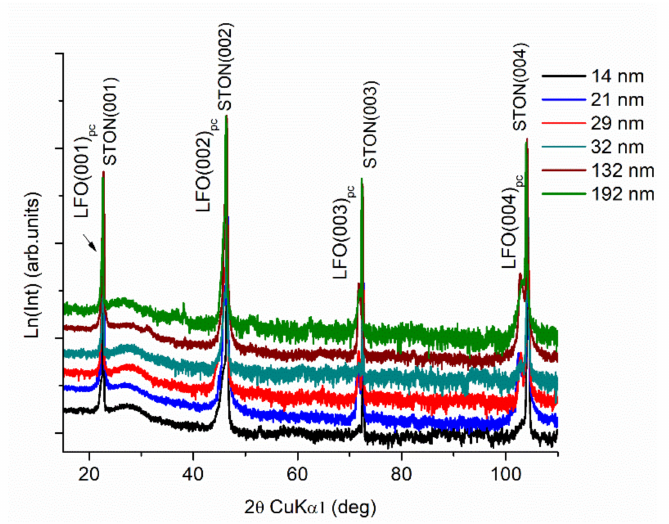
Figure 1. The XRD patterns of LFO films with different thicknesses deposited on